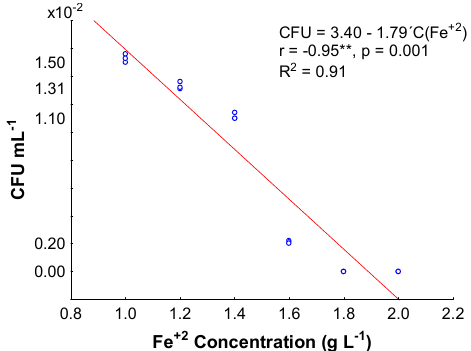
Figure 5. Final bacterial population of the strain MCC1 at different Fe +2 concentrations. C (Fe +2 ): concentration of Fe +2 . R : correlation coefficient. p : probability. R 2 : coefficient of determination without adjustment. **: highly significant.